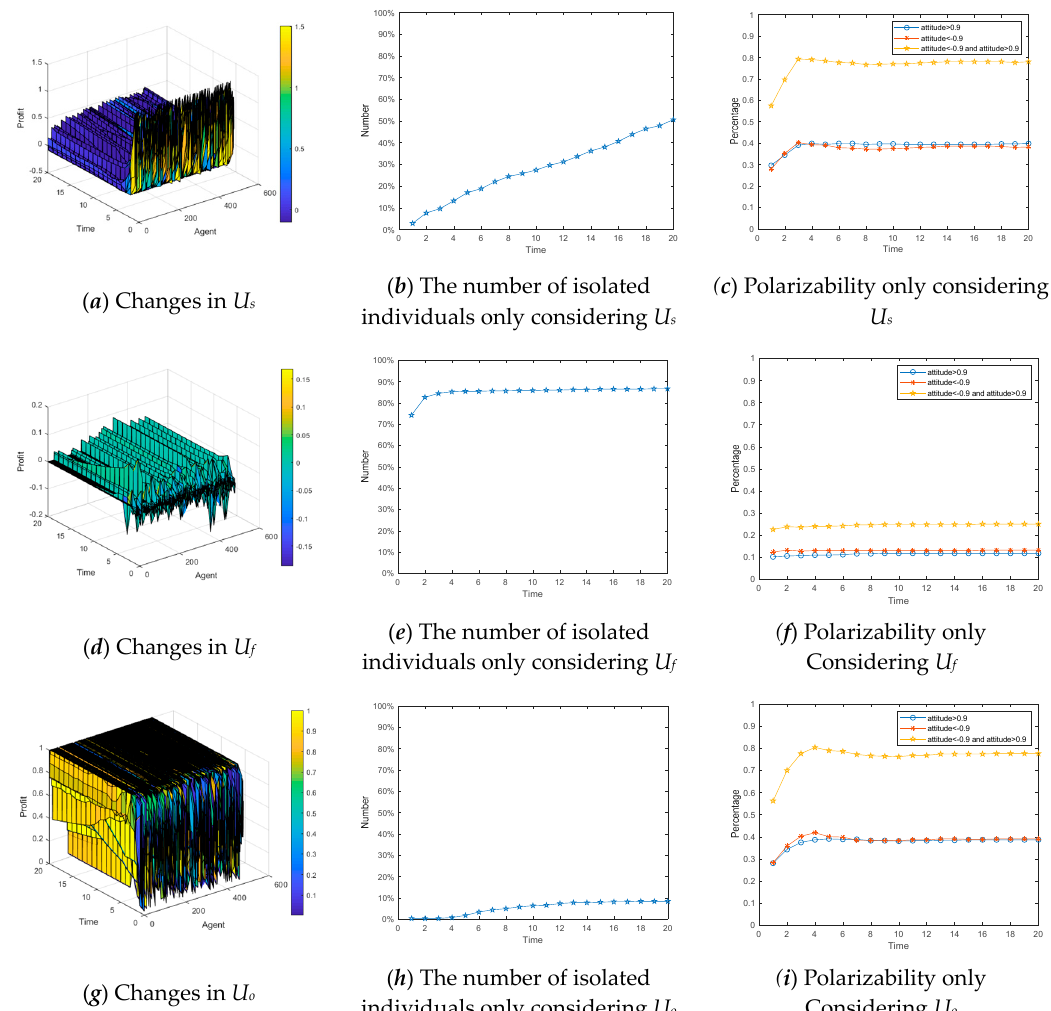
Figure 21. The influences of individual revenue on public opinion polarization.